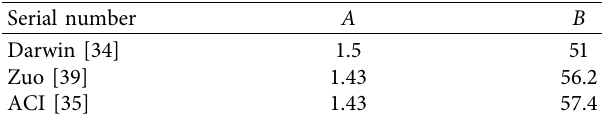
Table 6: Values of A and B in different